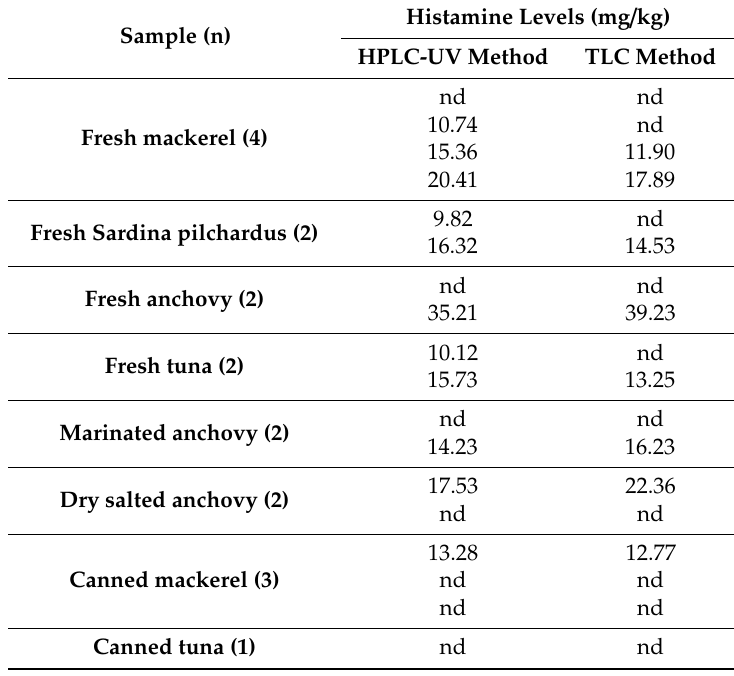
Table 3. Histamine level determination in fresh fish and fishery products using HPLC-UV and TLC / densitometry